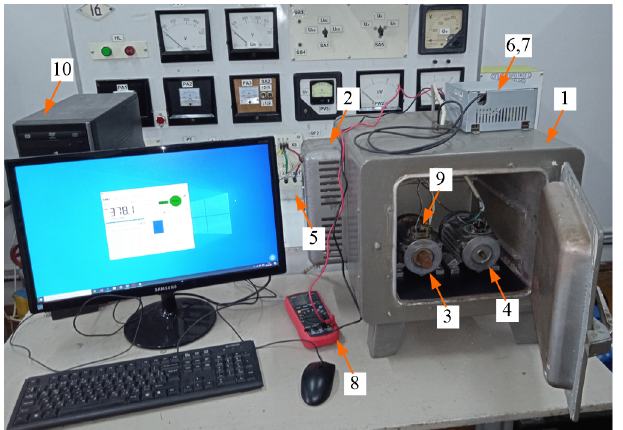
Figure 8. General view of the test bench: 1, test chamber; 2, adjustable air heater; 3, base EM; 4, tested EM; 5, power switch; 6, EM thermal protection device, which implements a new phase control method for EM SW temperature; 7, data collection system E502 manufactured by “LKard” (Moscow, Russian Federation), 8, miniature electronic thermometer (MET) with a remote digital temperature sensor 9; and 10, personal computer